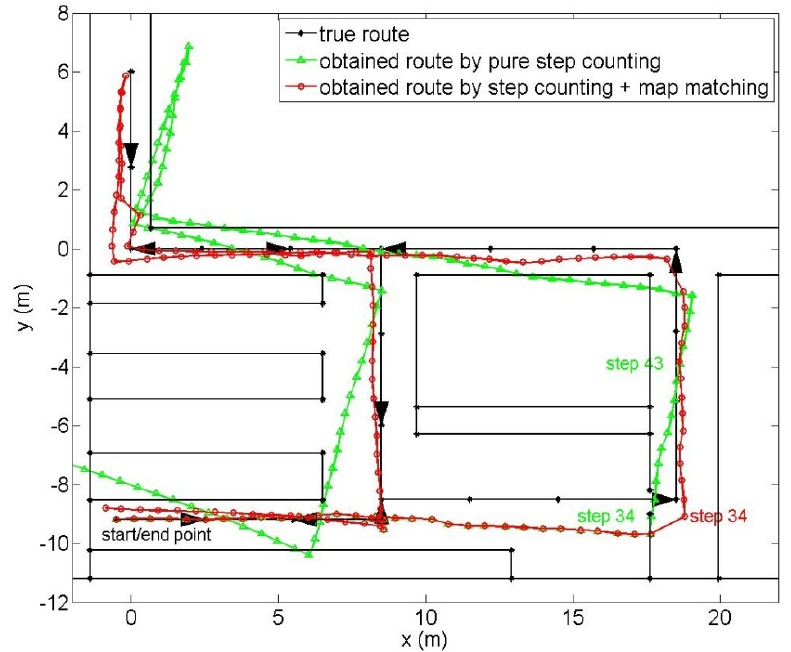
Figure 4. Performance comparison of pure step counting and the one with map